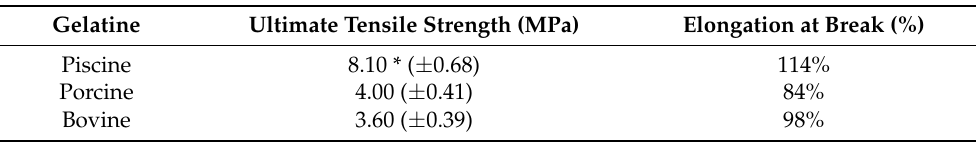
Table 1. Ultimate tensile strength (MPa) and elongation at break (%) of bioplastic generated with different gelatines ( n =